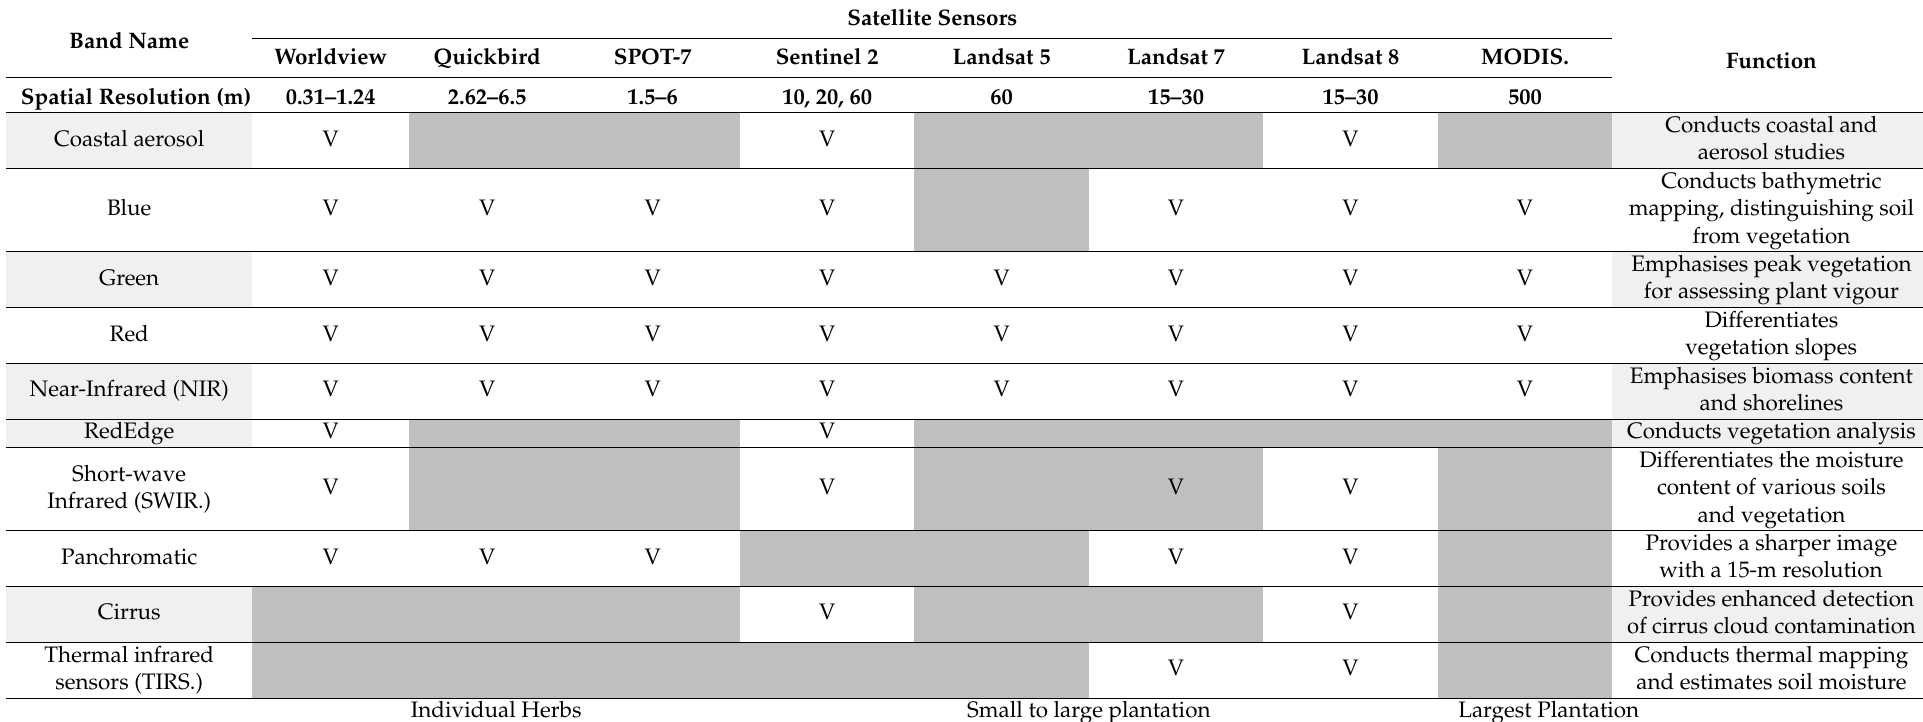
Table 2. A comparison of the characteristics and functions of MODIS with other satellite data